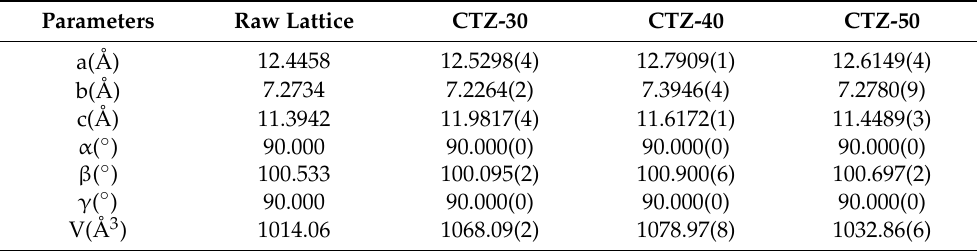
Figure 4. Rietveld refinement data map of the XRD of ( a ) CTZ-30, ( b ) CTZ-40 and ( c ) CTZ-50. Table 2. Cell parameters obtained by refining the zirconolite phase in the obtained glass-ceramics. Numbers presented in parentheses are error standard deviations of the corresponding parameters.